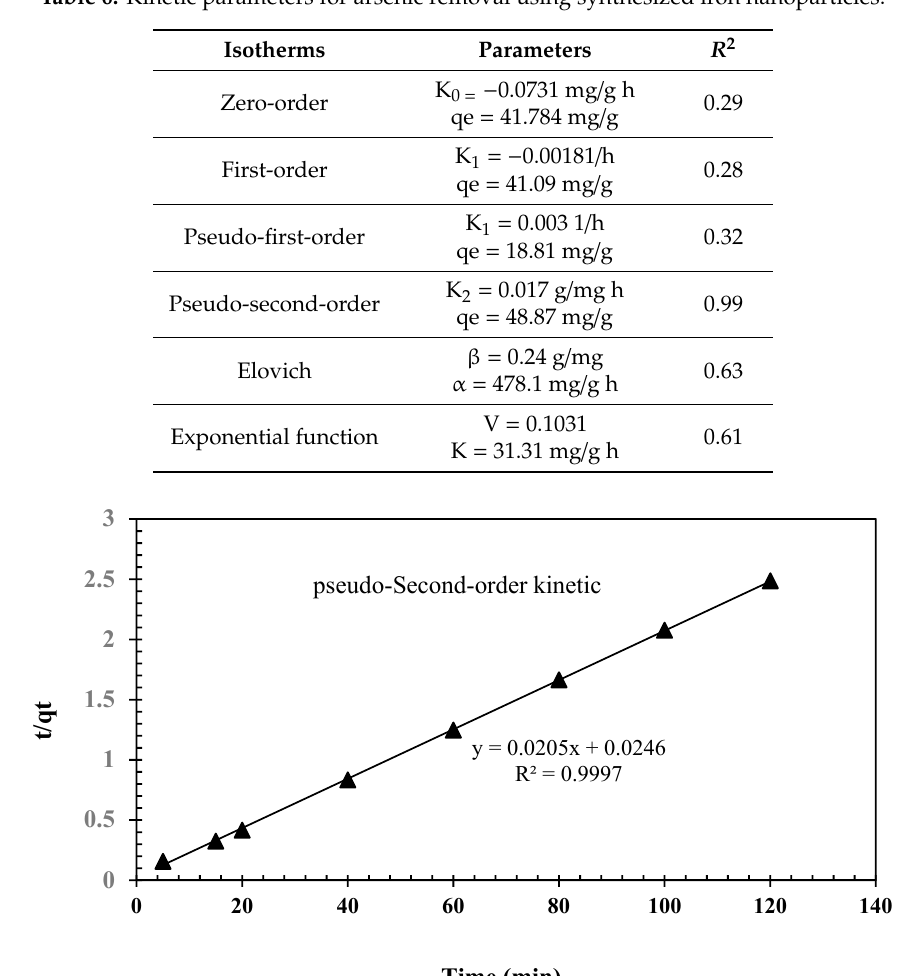
Figure 11. The pseudo-second-order kinetic model for arsenic removal using synthesized iron nanoparticles.